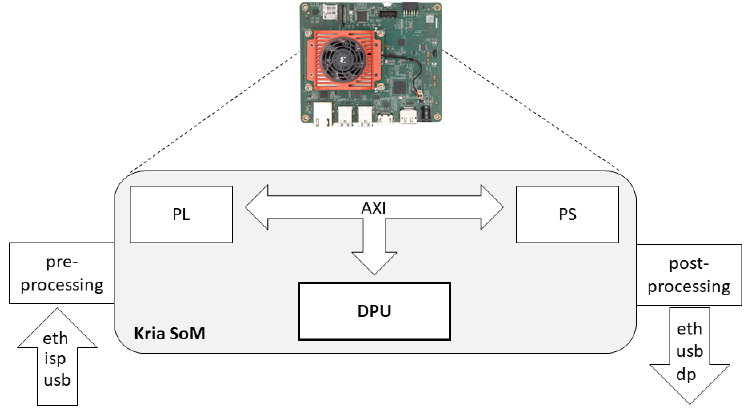
Figure 1. Kria SoM